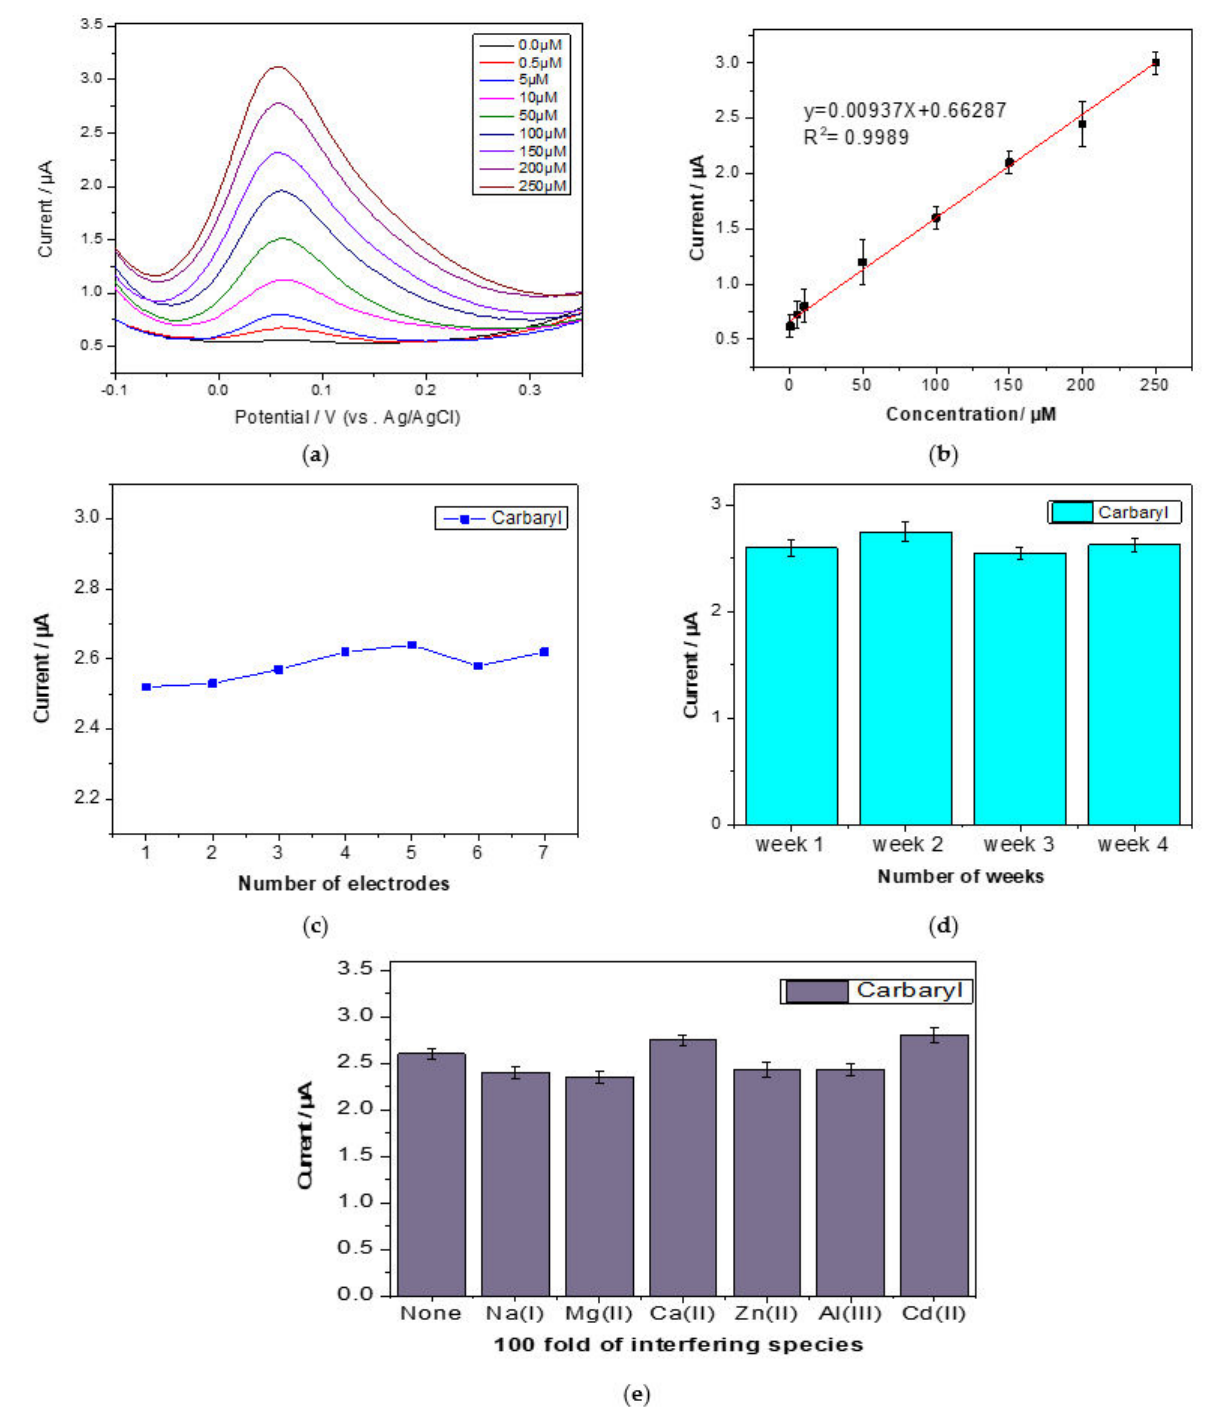
Figure 9. The voltammograms ( a ) and calibration ( b ) of carbaryl–phenol in 0.1 M acetate buffer (pH = 5) using rGO/AuNP/NA SPCE. The effect of ( c ) reproducibility, ( d ) stability and ( e ) selectivity on the current of carbaryl–phenol in 0.1 M acetate buffer (pH = 5) using rGO/AuNP/NA